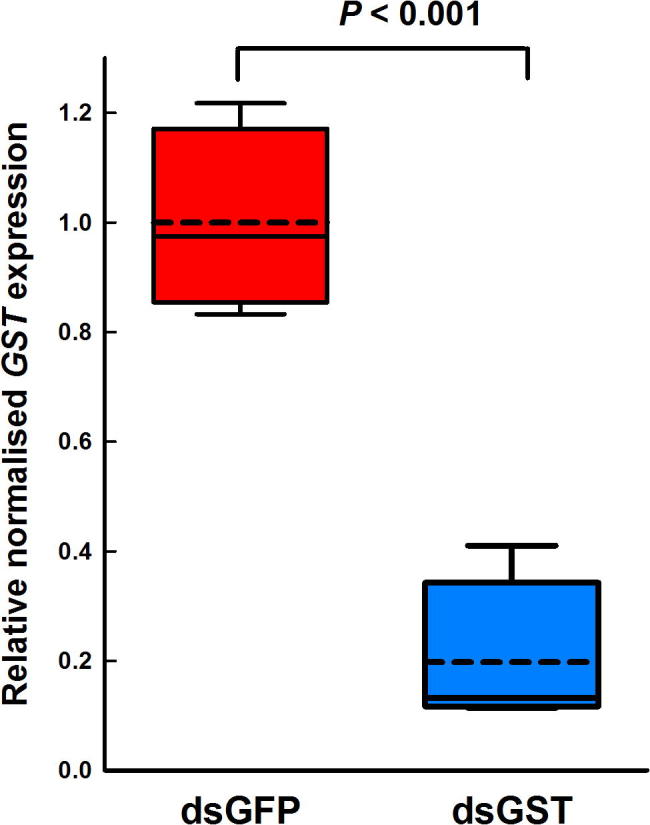
Relative normalised expression of GSTσ 96 h in Ctenocephalides felis after injection of double-stranded GFP (dsGFP) (n = 4) or dsGSTσ (n = 4). GSTσ expression is significantly lowered (P < 0.001) in the dsGSTσ – treated groups. Boxes indicate the interquartile ranges, whiskers the 10th and 90th percentiles, internal solid line indicates the median and dashed line indicates the mean. All data are normalised using two reference genes and expressed relative to the mean expression of the gene of interest in the dsGFP control.